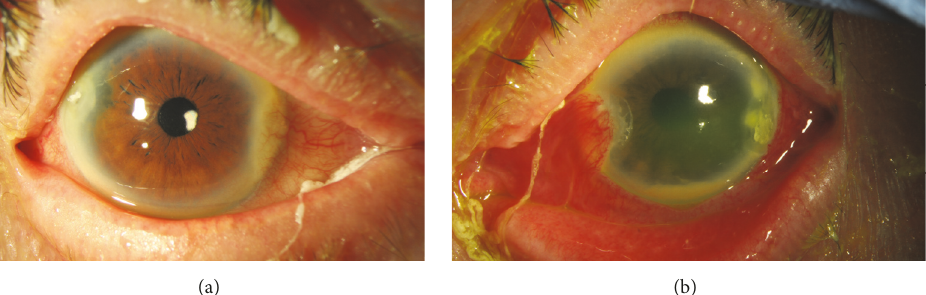
Figure 1: Slit-lamp photograph of the right eye (a) and left eye (b) demonstrates corneal stromal infiltrates localized at the temporal corneal lip and left eye with fluorescein staining of diffuse epithelia erosions and hypopyon.